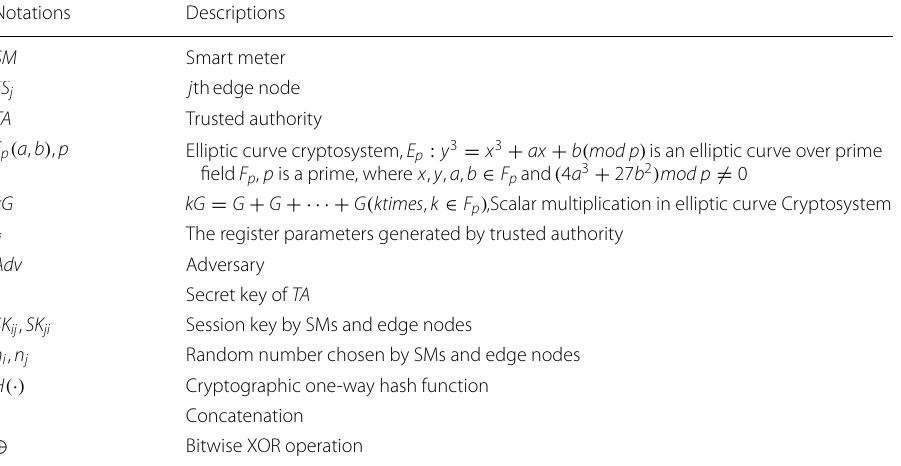
Table 1 Notations used in the proposed